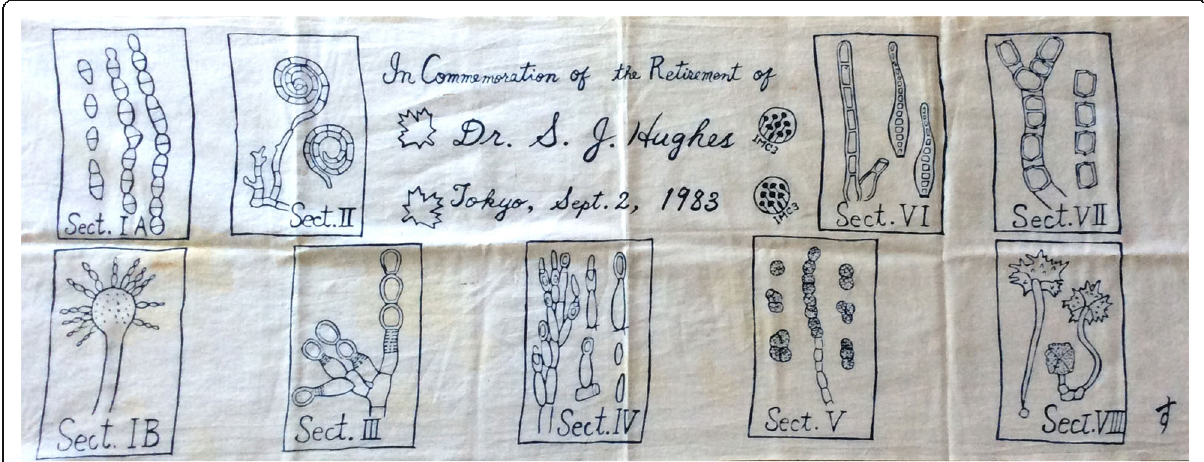
Fig. 17 Banner designed to commemorate “ Stan ” Hughes retirement showing the categories of conidiogenesis he recognized and presented to him at IMC2